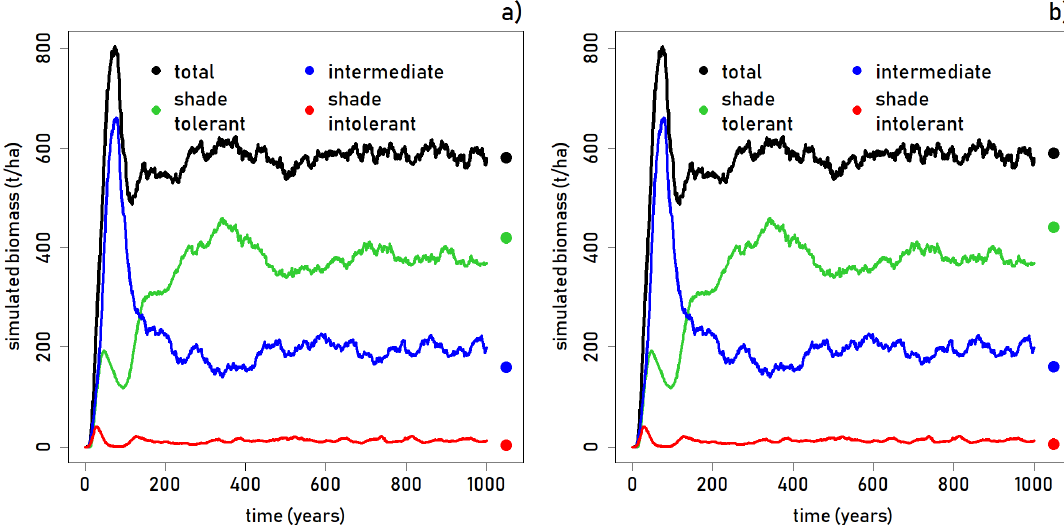
Figure 4. ( a ) Time series showing simulated biomass among the successional groups (shade intolerant, intermediate, shade tolerant) for 1000 years of simulation, as compared to Betampona forest (dots); ( b ) The same figure as on the left but comparing succession groups to Zahamena forest.